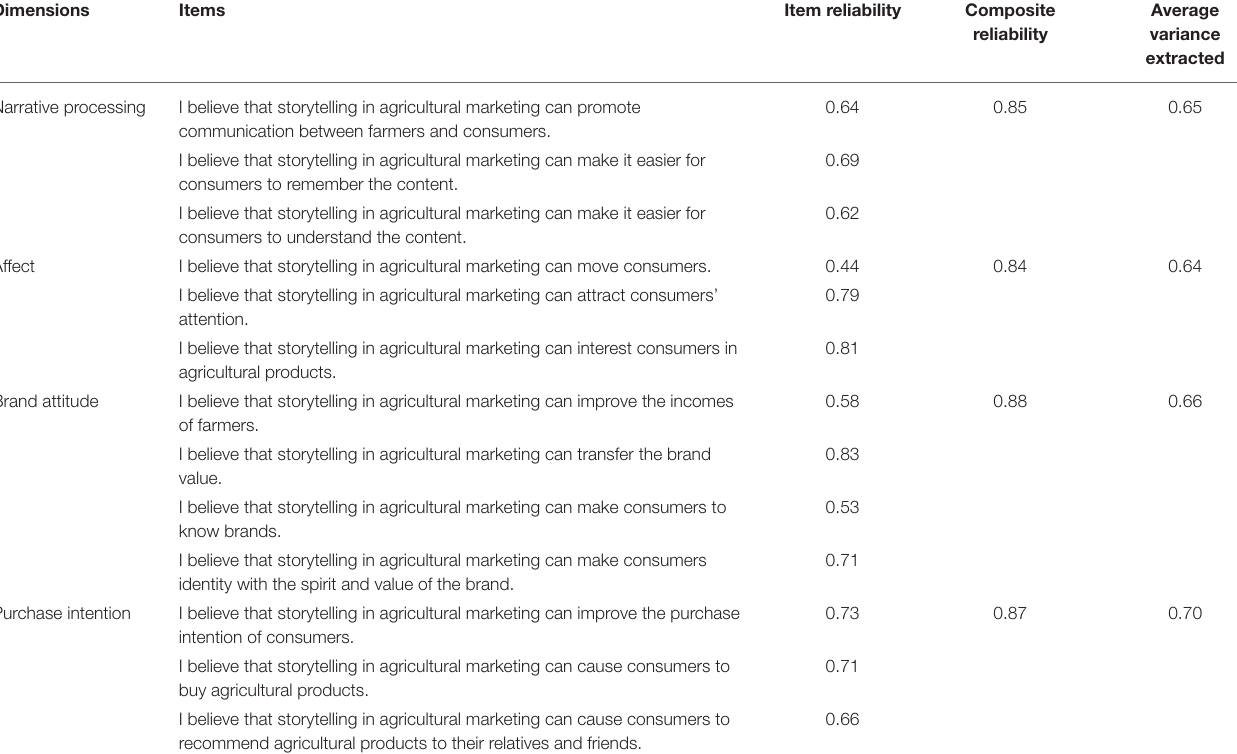
TABLE 2 | Item reliability, composite reliability, and average variance extracted of the storytelling in agricultural marketing effectiveness scale. Dimensions Items Item